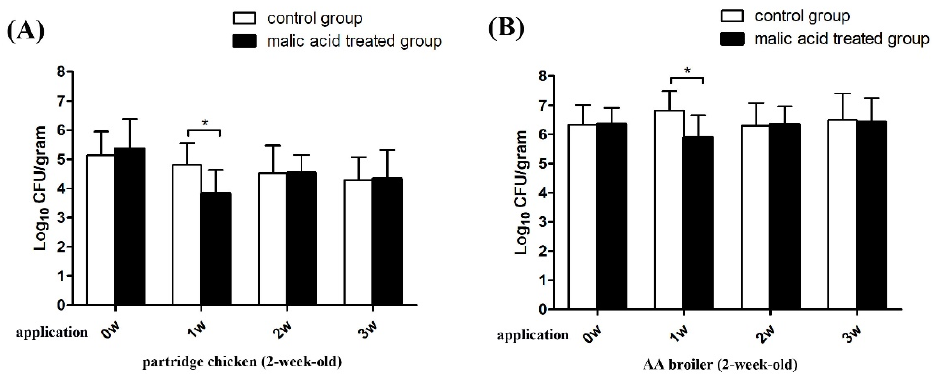
Figure 1. Campylobacter carriage in the cloaca of chickens after a long period of use of malic acid. Two week old partridge chickens ( A ) and AA broilers ( B ) were provided with the malic acid-supplemented drinking water for 3 weeks and cloacal swab samples were collected at the designated time to determine the Campylobacter carriage. Twenty chickens were assayed in each group, the data are presented as the mean ± SD, and asterisks indicate significant differences ( p < 0.05 *).